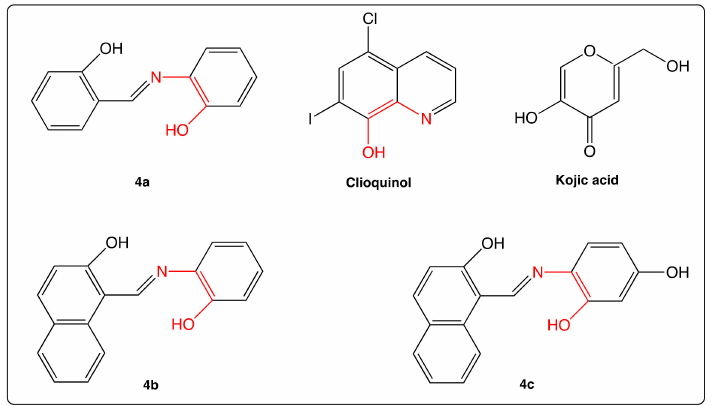
Figure 6. Structure of clioquinol, kojic acid and AZA-ST 4a – c